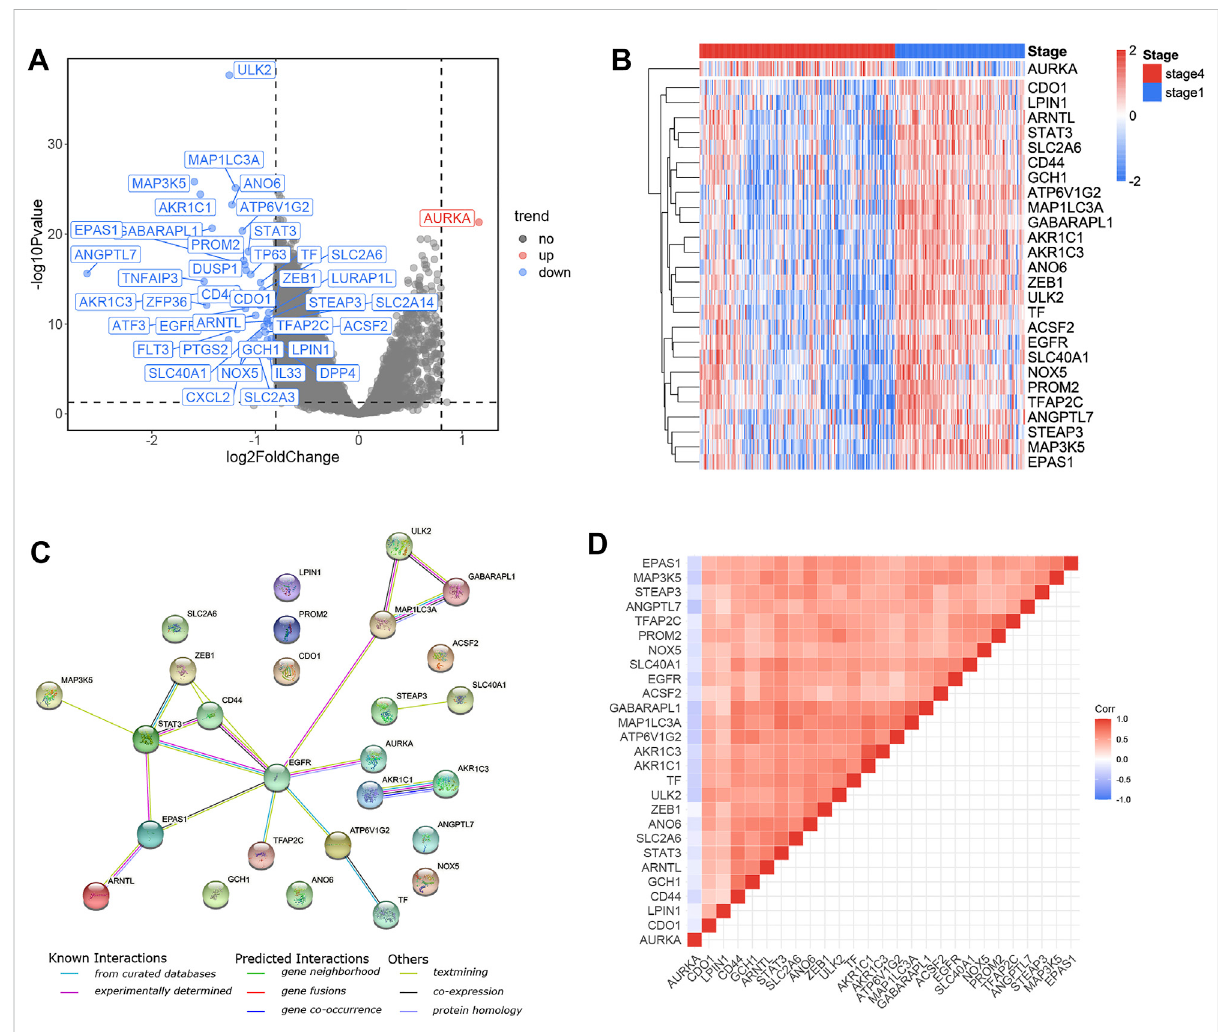
FIGURE 1 Identi fi cation of the candidate ferroptosis-related genes in the training cohort. (A) Volcano plot shows the differentially expressed 40 FRGs in the training cohort. (B) 26 genes were upregulated in stage 1 NB samples and one gene was upregulated in stage 4 NB samples. (C) The PPI network downloaded from theSTRINGdatabase indicatedtheinteractions amongthecandidate genes. Thecorrelation heatmap ofcandidate genesandthe correlation coef fi cients are represented by different colors. (D) The correlation heatmap shows the expression values of the identi fi ed 27 ARGs associated with OS in the training